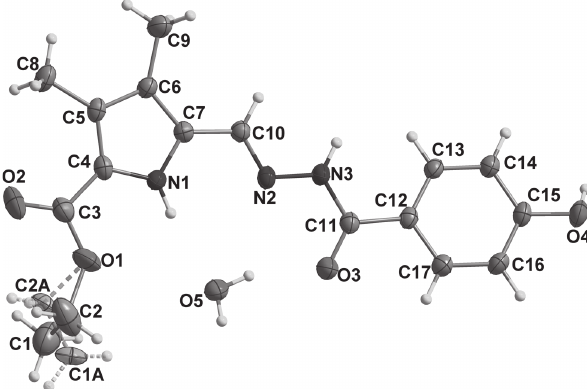
Table 2: Fractional atomic coordinates and isotropic or equivalent isotropic displacement parameters (Å 2